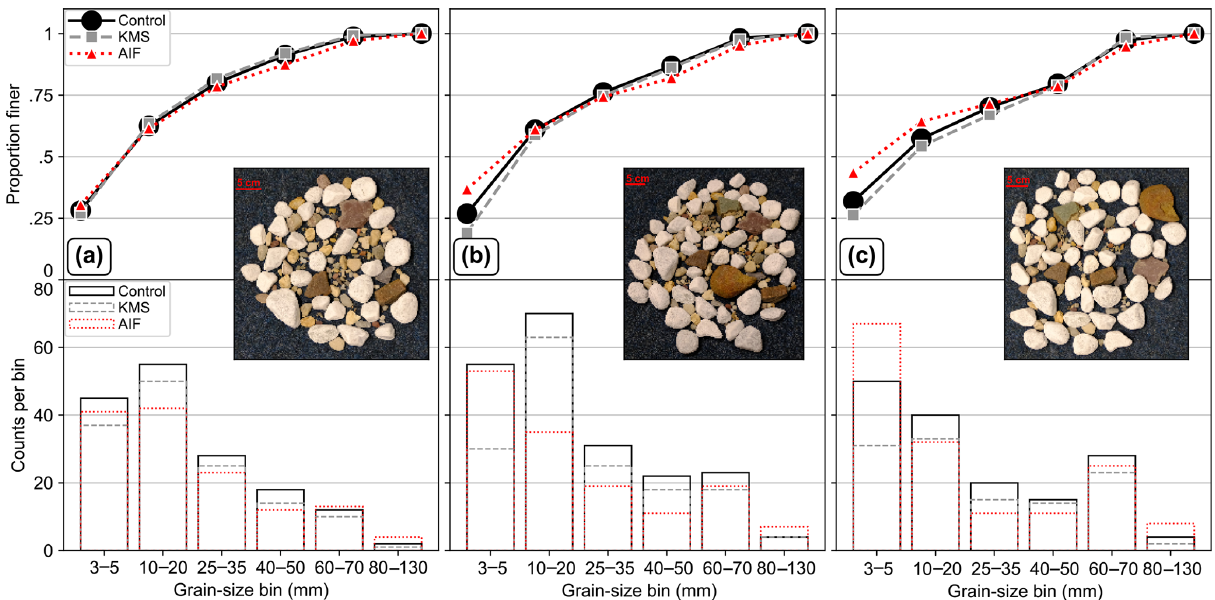
Figure 4. Result of KMS (gray, dashed lines) and AIF (red, dotted lines) on the three experimental lab setups (a–c) with known grain inputs in six size classes (black line), measured as the grain a axis: (a) log normal, (b) log normal with increased number of all classes, including fines, and (c) skewed bimodal with increased number of coarser grains. Bottom row shows the counts per bin and the top row shows the resulting grain-size distribution. The images are 0.26mmpixel − 1 (24 megapixels).